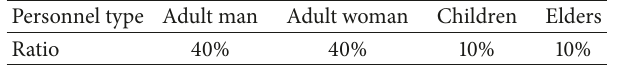
Table 1: Personnel